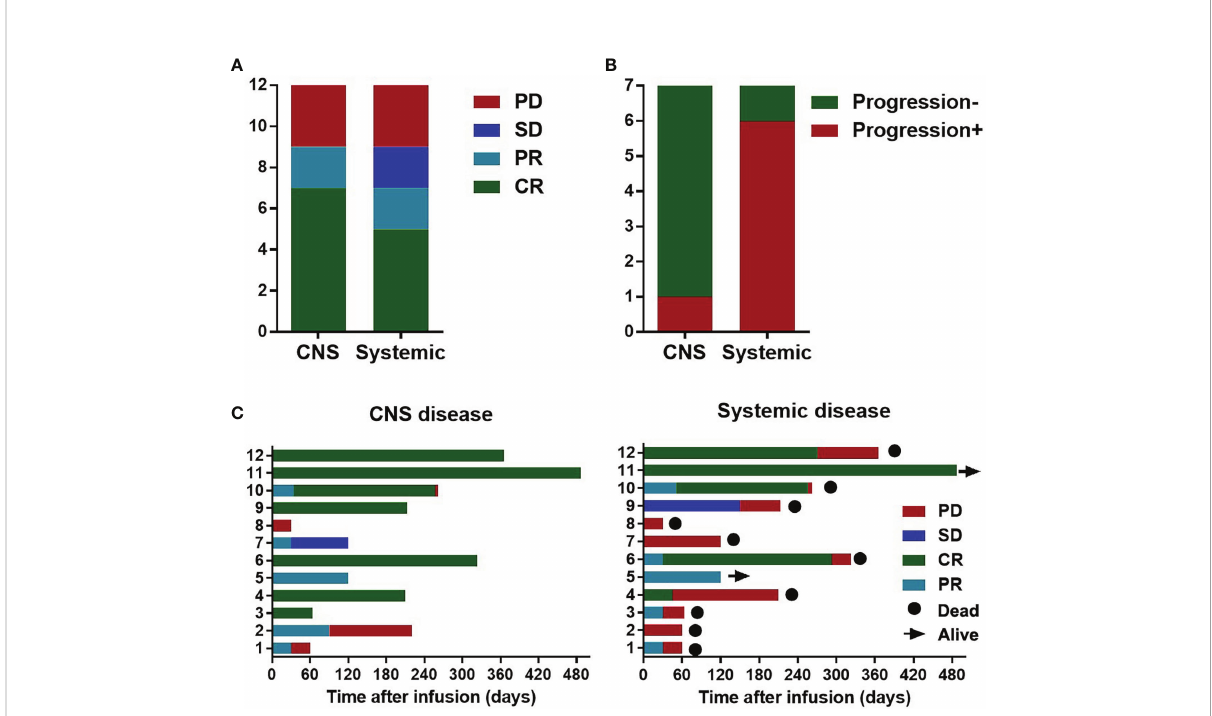
FIGURE 2 Disease response and survival of the 12 secondary Central Nervous System Lymphoma (CNSL) patients with systemic involvement. (A) Responses of the CNS and systemic disease after CAR-T cell infusion in the 12 secondary CNSL patients with systemic involvement; (B) Disease status at the data cutoff date for 7 patients with central nervous system disease complete remission (CR). (C) Disease status and survival of the 12 patients with secondary CNSL after CAR-T cell